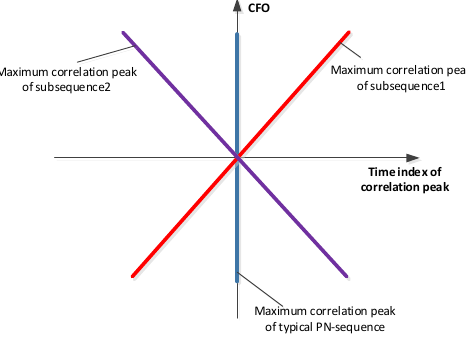
Figure 9. Subsequence ambiguity in time and frequency shift.